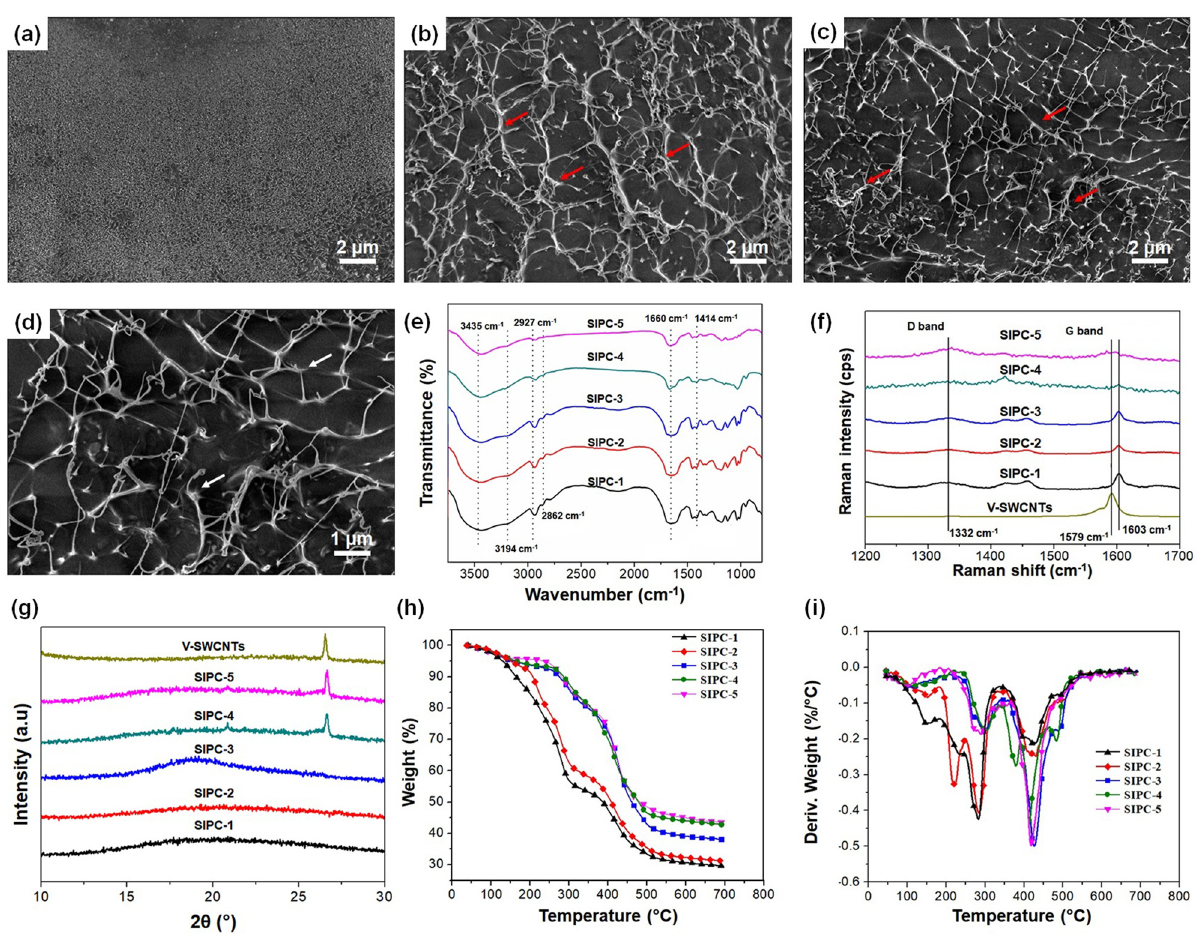
Figure 4: FE - SEM images of ( a ) SIPC - 1, ( b ) SIPC - 4, and ( c and d ) SIPC - 5 ( the red arrows indicate the SWCNT bundle networks and the white arrows show the embedment of SWCNTs in the polymer matrix ) . ( e ) FTIR spectra, ( f ) Raman spectra, ( g ) XRD patterns, ( h ) TG curves, and ( i ) DTG curves of the SIPC